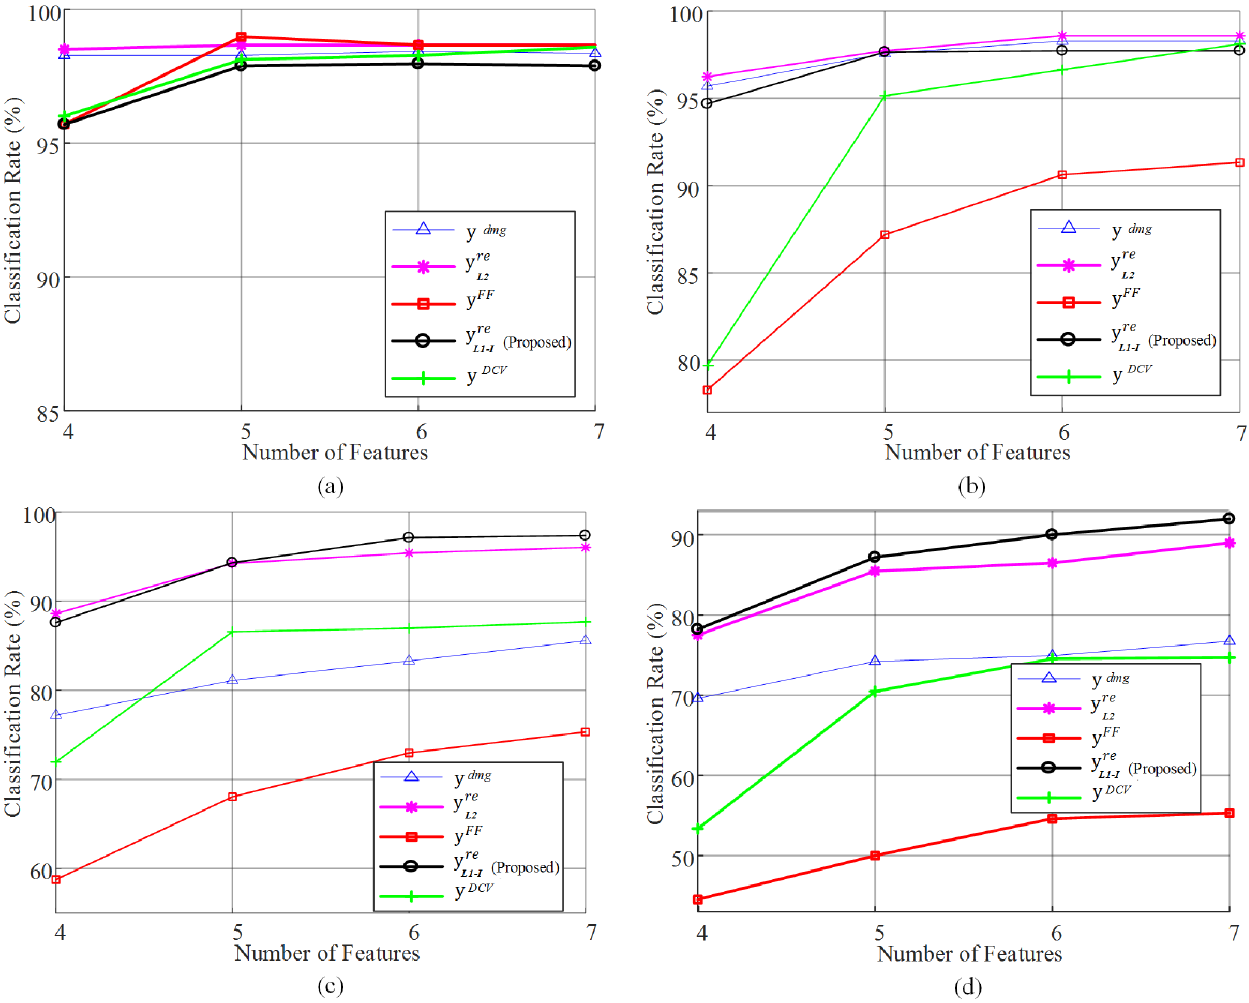
Fig 9. Classification rates for various dimensions of the feature space. (a) 5% data loss (b) 10% data loss (c) 15% data loss (d) 20% data loss.